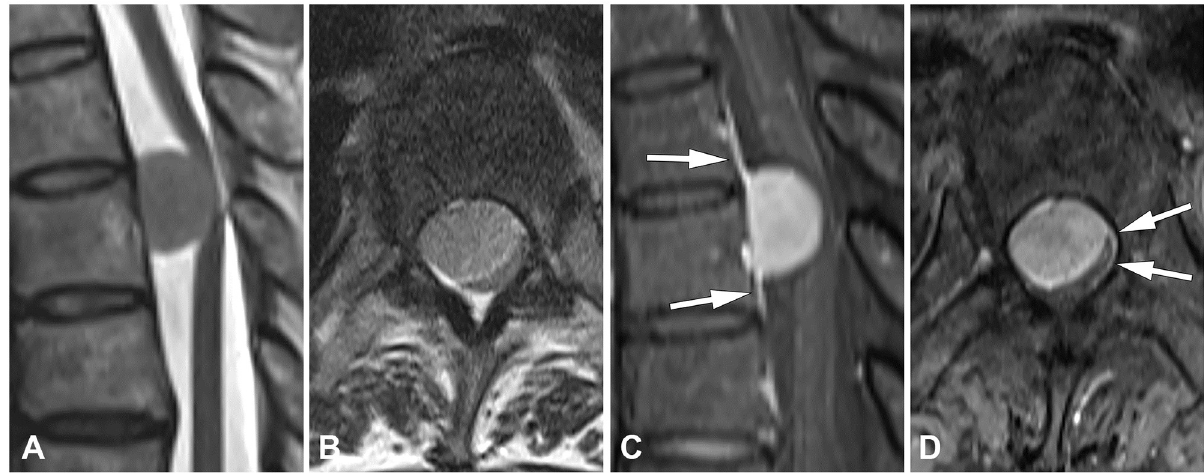
Fig 4. A meningioma in a 53-year-old woman. ( A ) Sagittal and ( B ) axial T2-weighted images show an intradural extramedullary mass on the T12 level that is slightly hyperintense than the spinal cord ( C ) Sagittal and ( D ) axial fat-suppressed contrast-enhanced T1-weighted images show thickening with enhancement of dura mater adjacent to the tumor that tapers away from it, representing dural tail sign (arrows).